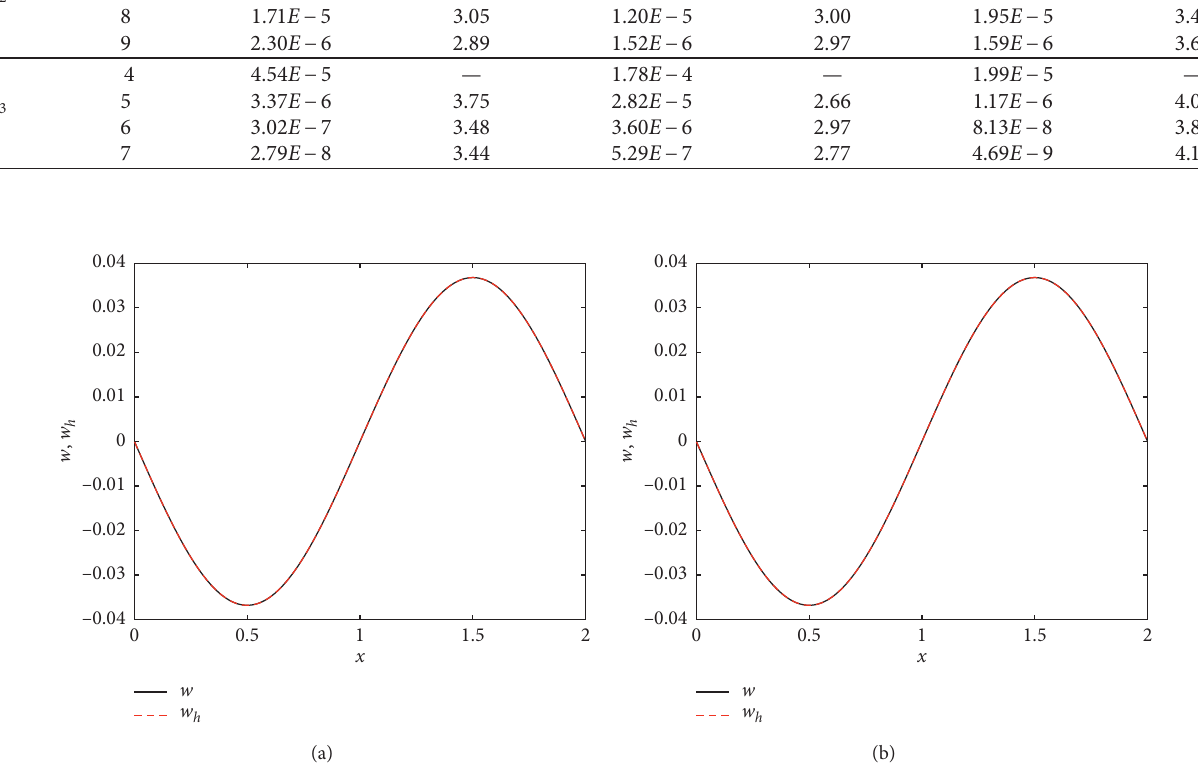
Figure 4: The exact solution w (solid line) and LDG solution w